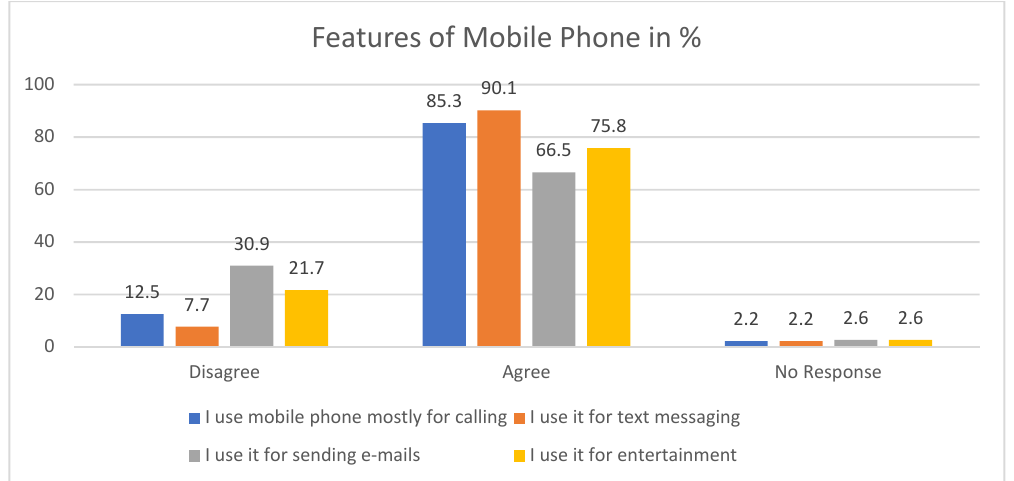
Figure 5. Mobile phone features used by young people in daily life activities.